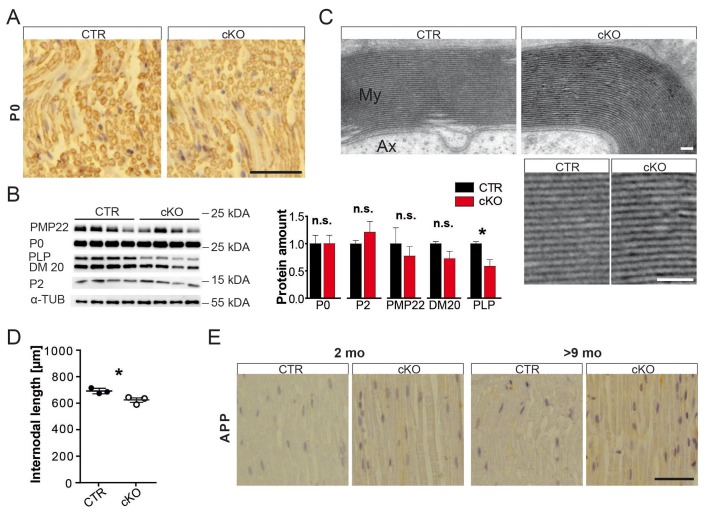
Myelin analysis of mouse sciatic nerves.(A) Chromogenic immune-staining for myelin protein zero (MPZ/P0) on paraffin-embedded sciatic nerve sections at 2 months. Scale bar, 50 µm. (B) Abundance of major PNS myelin proteins P0 and PMP22, as well as fatty-acid-binding protein P2, and DM20 were not significantly altered by quantification of Western blot analysis of sciatic nerve lysates obtained at the age of 2 months (n = 4; each normalized to control levels; 1.0). Only the covalently lipid-binding protein PLP showed significant reduction in mutant as compared to control nerves. Alpha-Tubulin served as loading control. Statistics: mean ± s.e.m. *p<0.05; **p<0.01; ***p<0.001; n.s., not significant, Student’s T-test. (C) Electron micrographs of sciatic nerve cross-section showing myelin sheaths of animals aged 2 months. Scale bars, 10 nm. (D) Internodal lengths measured using teased fibers of 2-month-old PEX5 mutant and control animals. Statistics: n = 3, mean ± s.d. *p<0.05, Student’s T-test. (E) Chromogenic immune-staining for APP on longitudinal paraffin-embedded sciatic nerve sections. Scale bar, 50 µm.